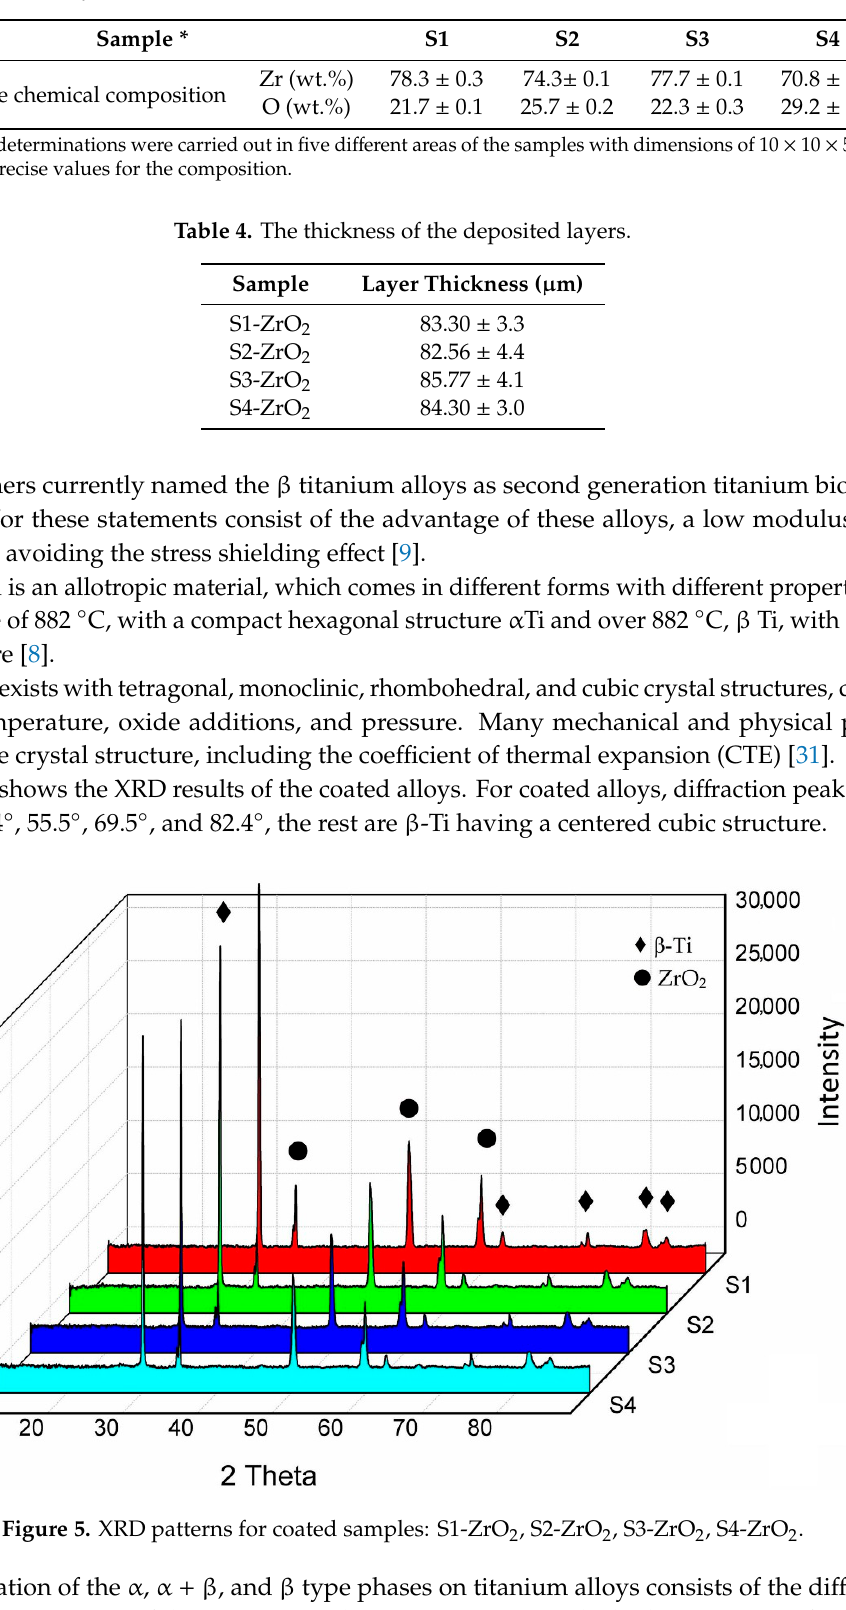
2 , S2-ZrO 2 , S3-ZrO 2 , S4-ZrO 2